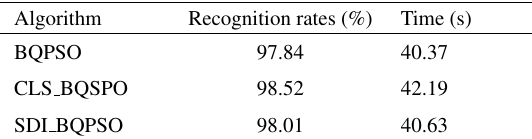
Table 2. Accuracy assessments of the three